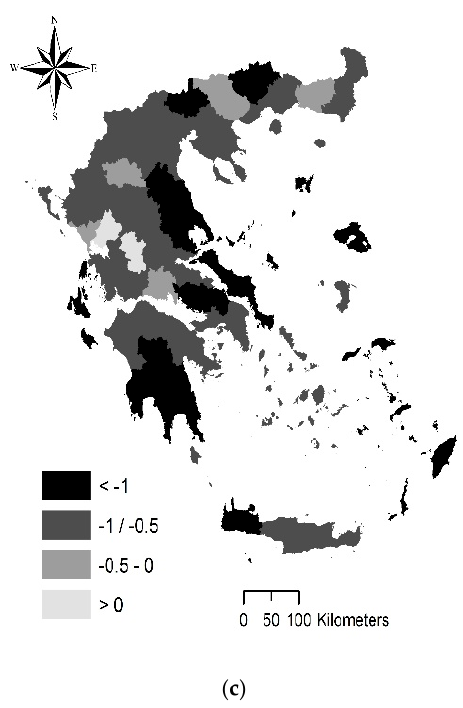
Figure 3. Gender gap (males—females) in the mean age at marriage (years) in Greece: 1980 ( a ), 2017 ( b ) and annual (per cent) rate of change in gender age differentials over time ( c ).